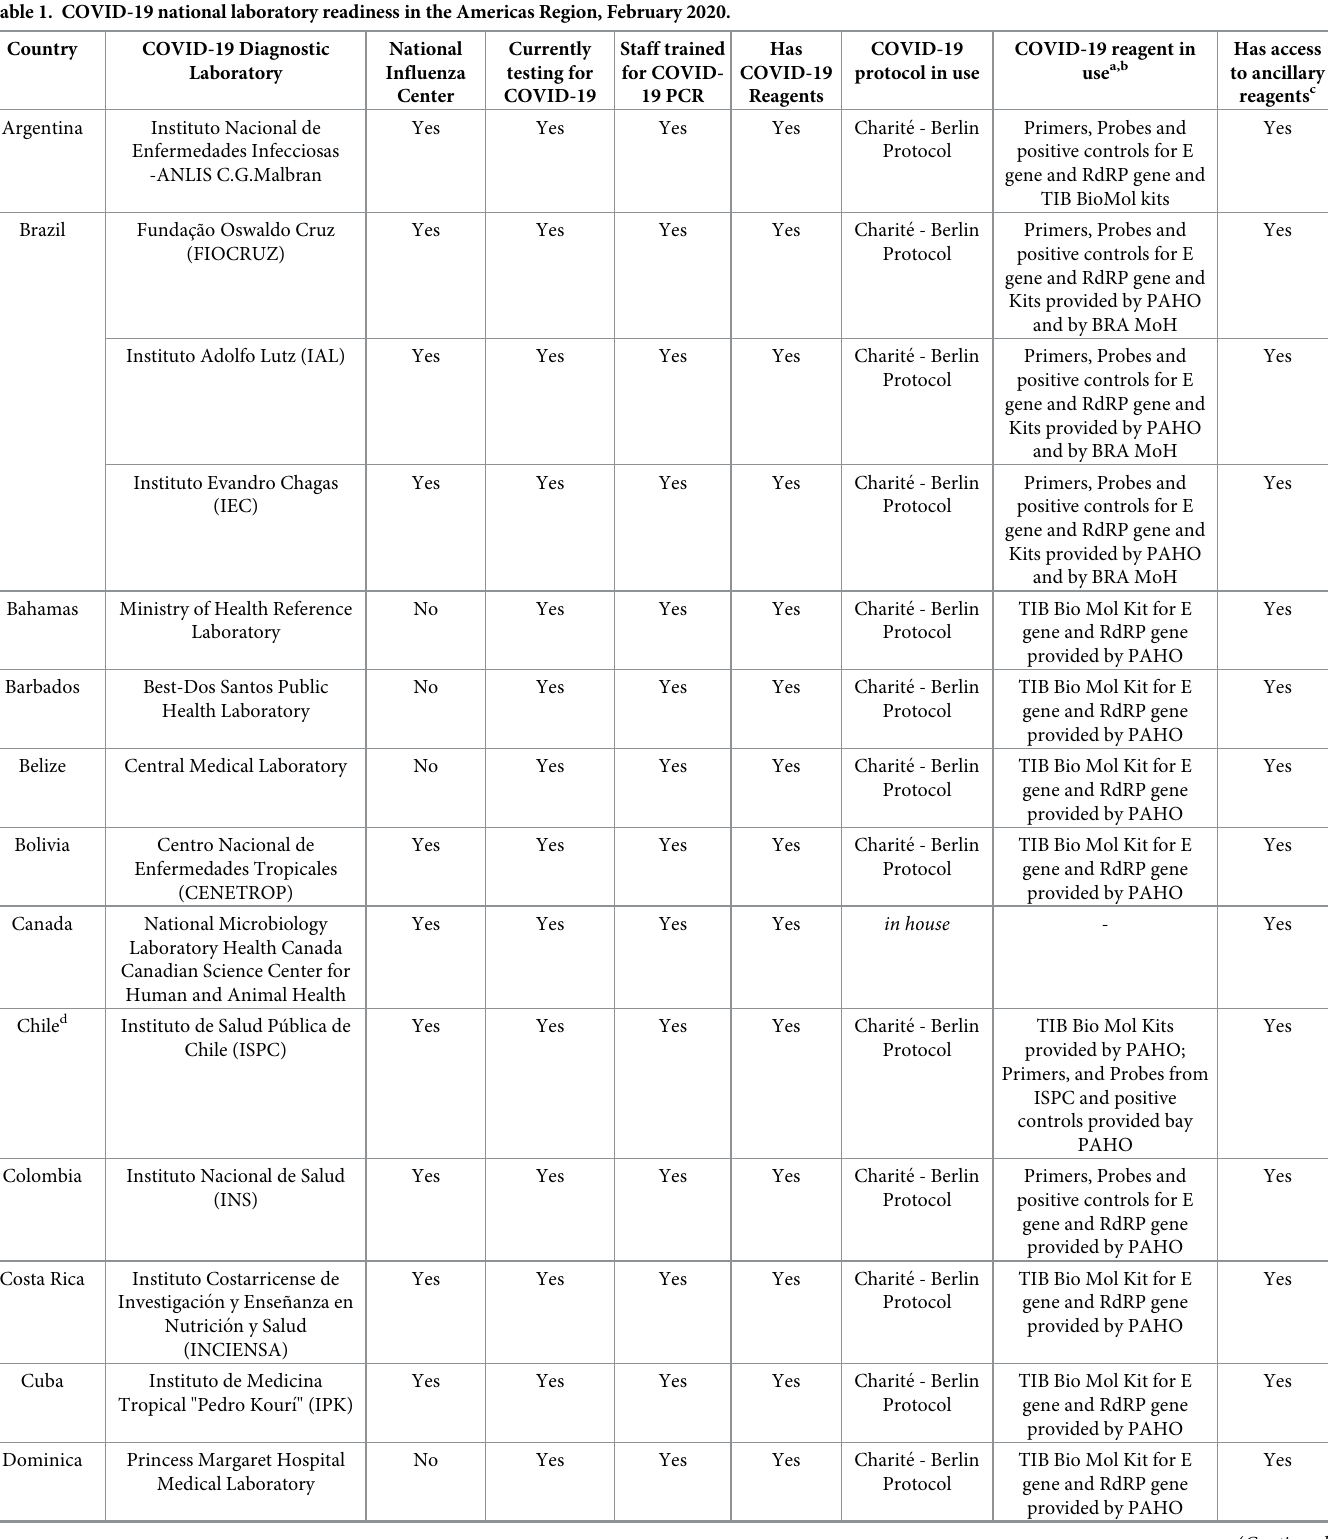
Table 1. COVID-19 national laboratory readiness in the Americas Region, February 2020.